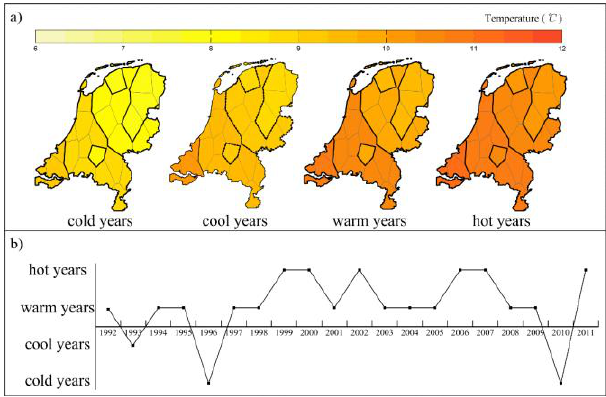
Figure 3. Spatio-temporal patterns in Dutch yearly temperature dataset (adapted from (Wu, Zurita-Milla et al. 2015))